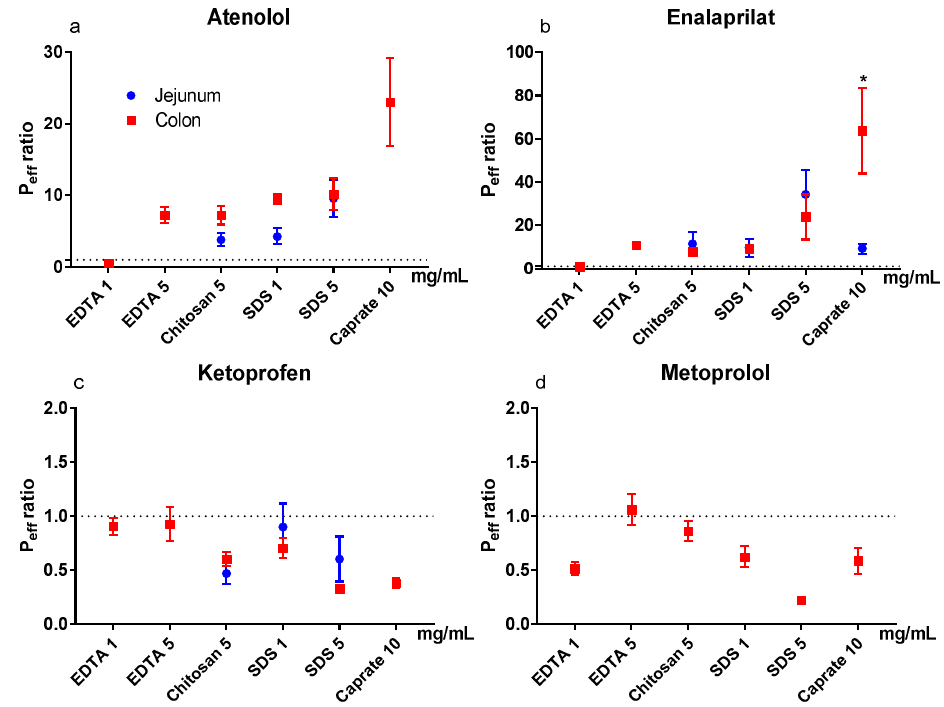
Figure 4. The mean ± SEM rat jejunal (historical data) and colonic lumen-to-blood intestinal e ff ective permeability (P e ff ) ratio ( n = 6) of: ( a ) atenolol, ( b ) enalaprilat, ( c ) ketoprofen, and ( d ) metoprolol, after intestinal perfusions of a control solution for 60 min, followed by a 75-min perfusion of any of six permeation enhancing (PE) test formulations [11,12]. The control and test formulation perfusate pH was 6.5 for the PEs: sodium dodecyl sulfate (SDS) at 1 and 5 mg / mL, chitosan at 5 mg / mL, and ethylenediaminetetraacetic acid (EDTA) at 1 and 5 mg / mL. The control and test formulation perfusate pH was 7.4 for caprate at 10 mg / mL. All formulations were solutions, except caprate which was a suspension (its solubility at pH 7.4 is 5 mg / mL). There is no jejunal historical data for metoprolol and only jejunal historical data for EDTA and caprate for enalaprilat. A * represents a significant di ff erence in jejunal and colonic P e ff (two-way ANOVA, Holm–Sidak).